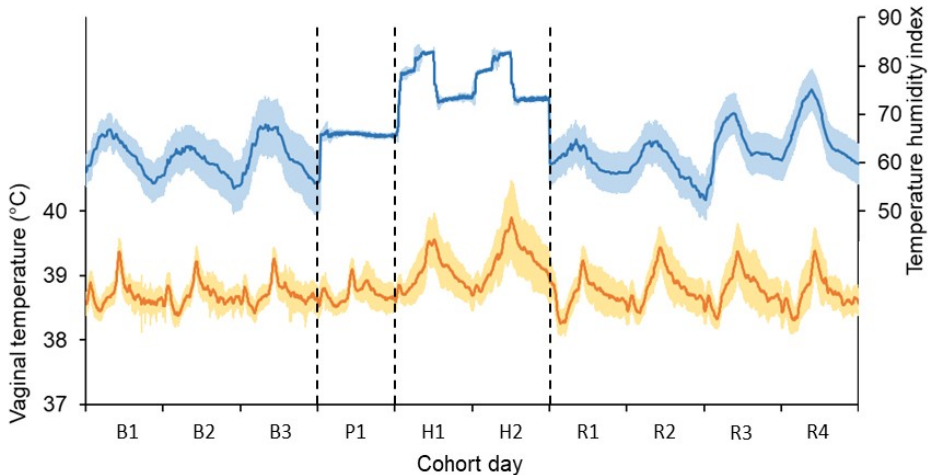
Figure 2. Mean environmental conditions experienced by the cows (blue line) and mean vaginal temperature of all cows (orange line) during the base period (B), pre-challenge (P), heat challenge (H), and recovery period (R). Shading bands show ± one standard deviation from the mean. The pre-challenge and heat challenge were generated in controlled-climate chambers. Cows were in ambient conditions at all other times.